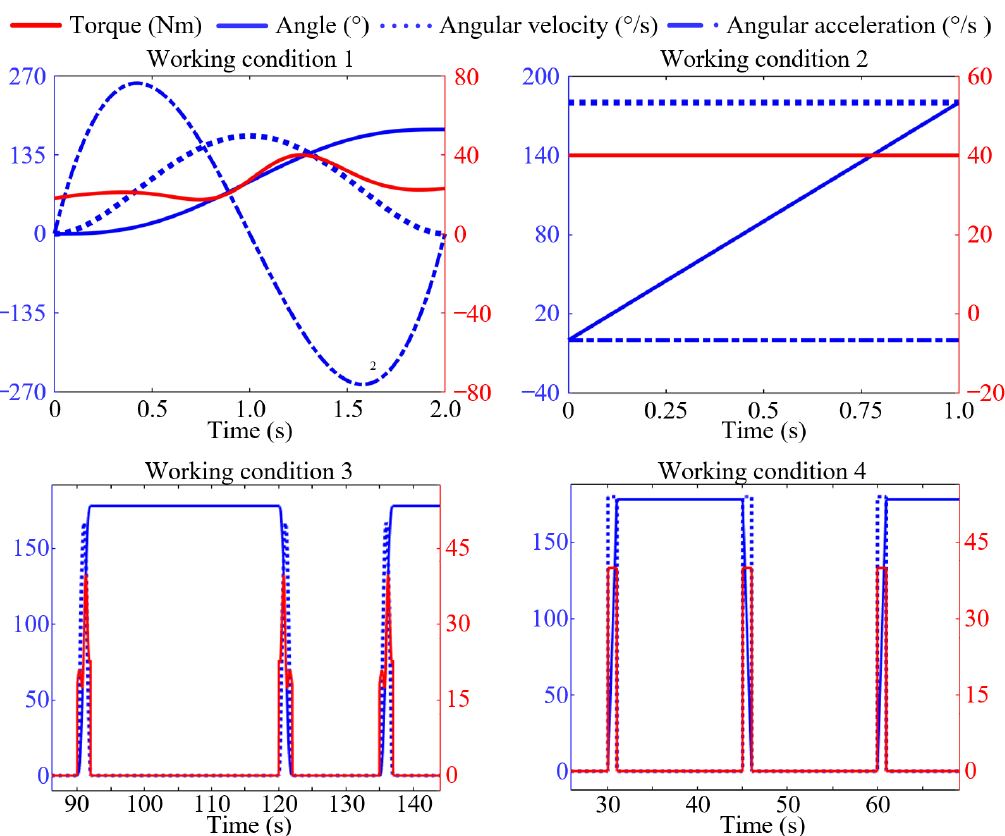
Figure 9. Load spectrum of four working conditions.